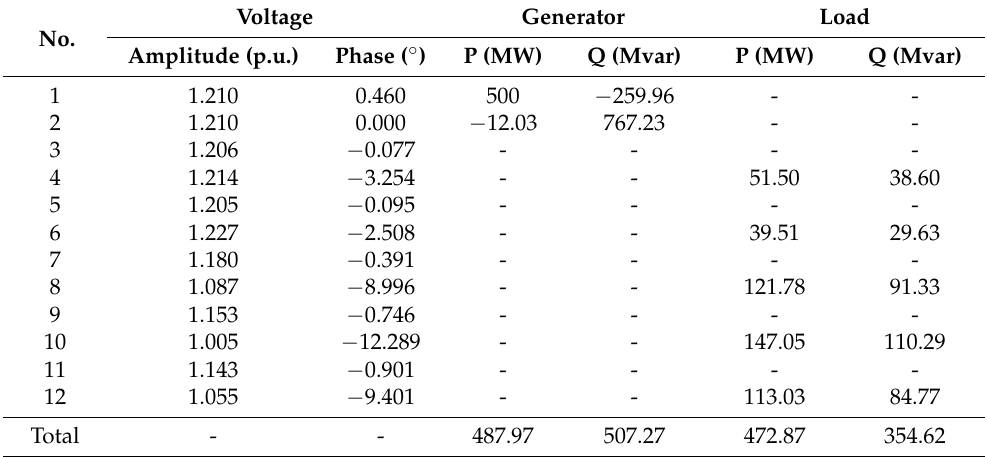
Table 19. Calculation results of the different nodes in the power supply